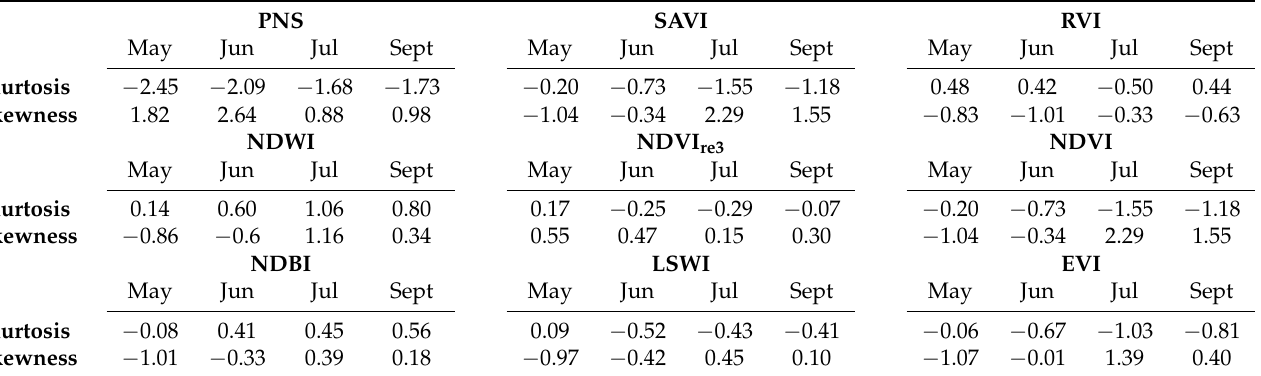
Table 3. Kurtosis and skewness of features in different periods.